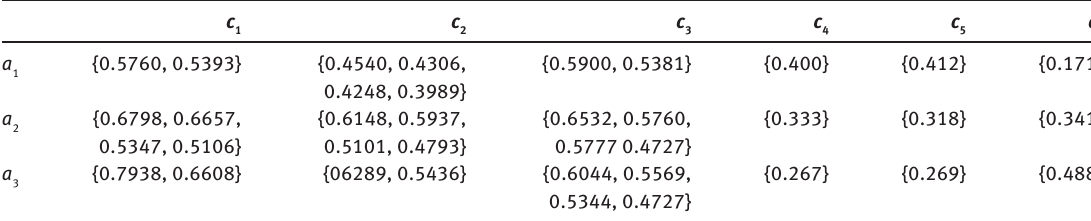
Table 7: The Collective Hesitant Fuzzy Decision Matrix R .